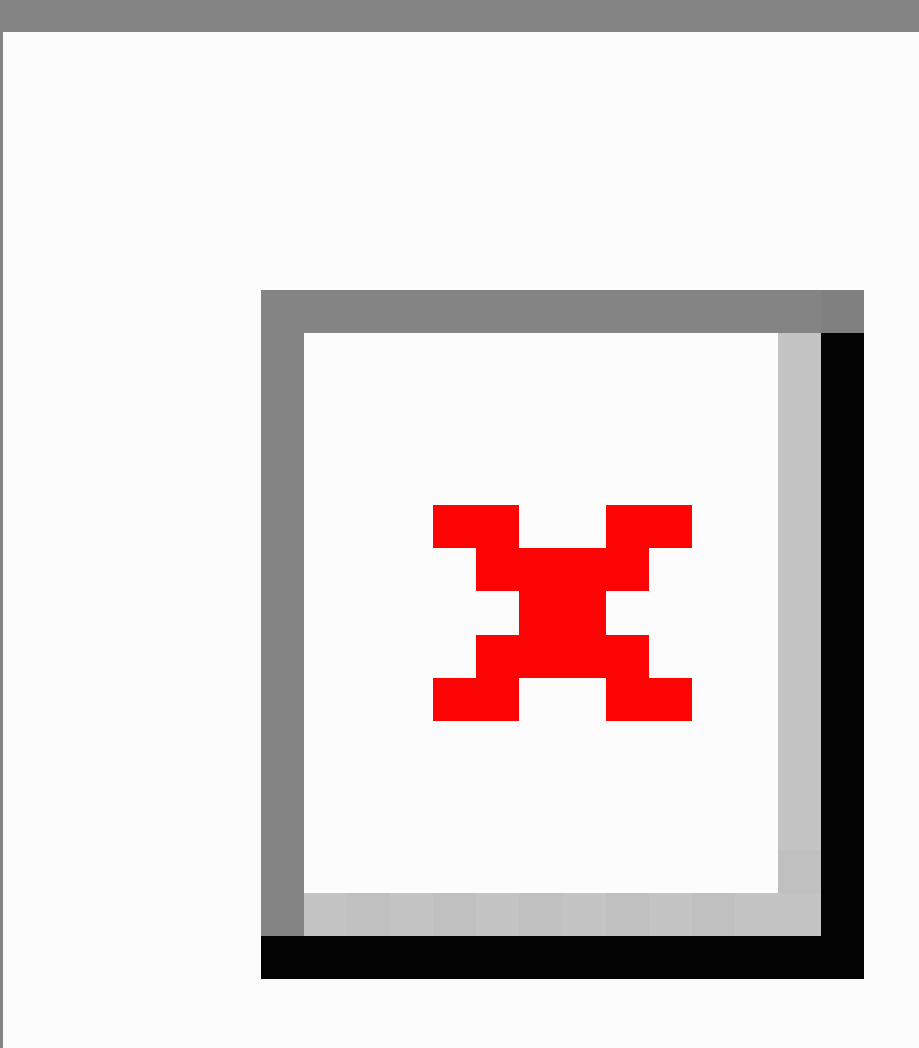
Figure 1. Screenshot from DASH Mobile: Self-reported DASH diet